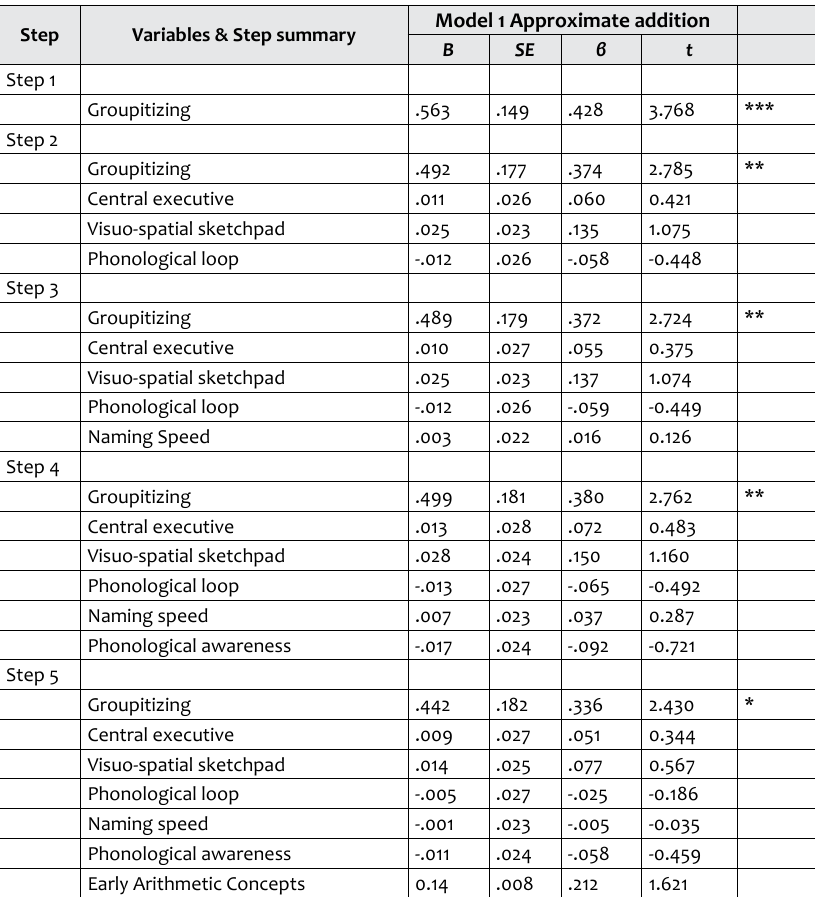
Table 4: Regression analyses of approximate arithmetic: unique contribution of groupitizing, working memory, naming speed, phonological awareness and early arithmetic